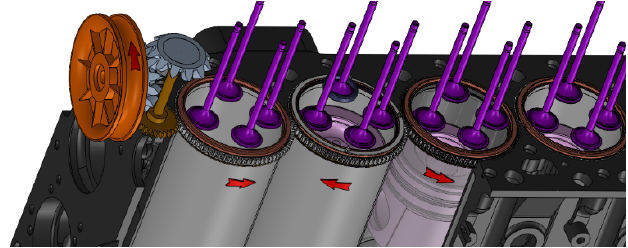
Figure 17. CAD representation of the multi-cylinder RLE. The critical components are identical to the current prototype, and the model of the block is the production engine, so a direct modification is